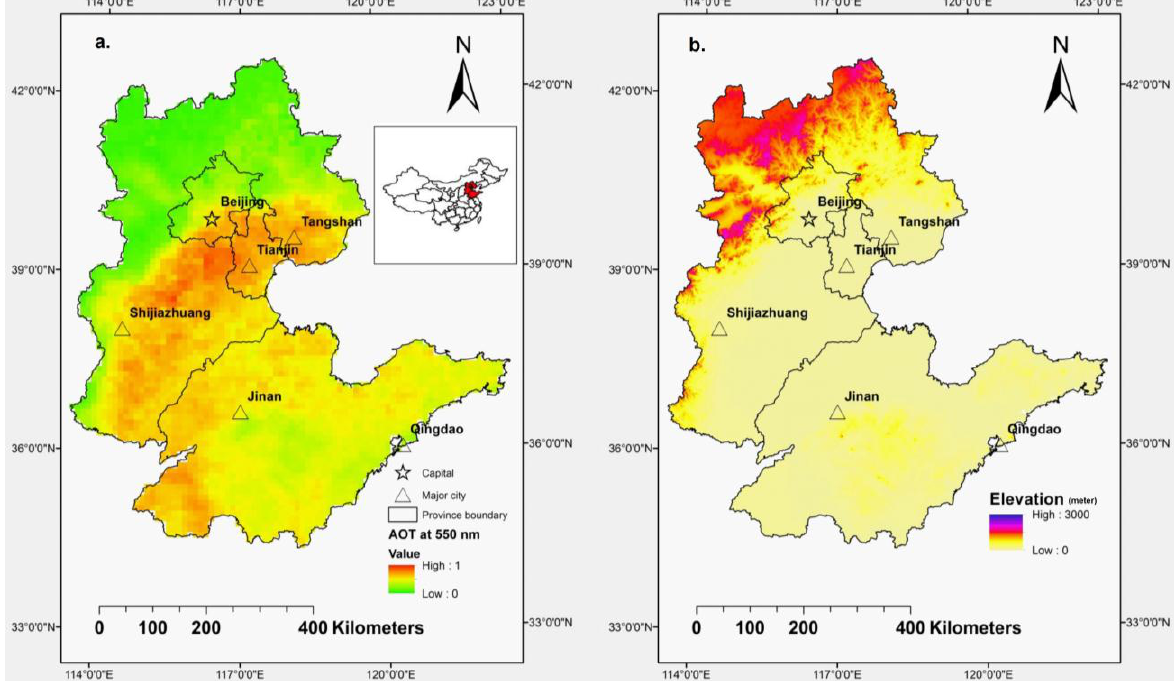
Figure 1. Study area ( a ) the mean MODIS Aerosol Optical Thickness (AOT) of 1–11 November 2002–2013; ( b ) Elevation. The city boundary of the six cities is provided by Data Center for Resources and Environmental Sciences, Chinese Academy of Sciences (DCRES, CAS). The Digital Elevation Model (DEM) was derived from the Shuttle Radar Topography Mission